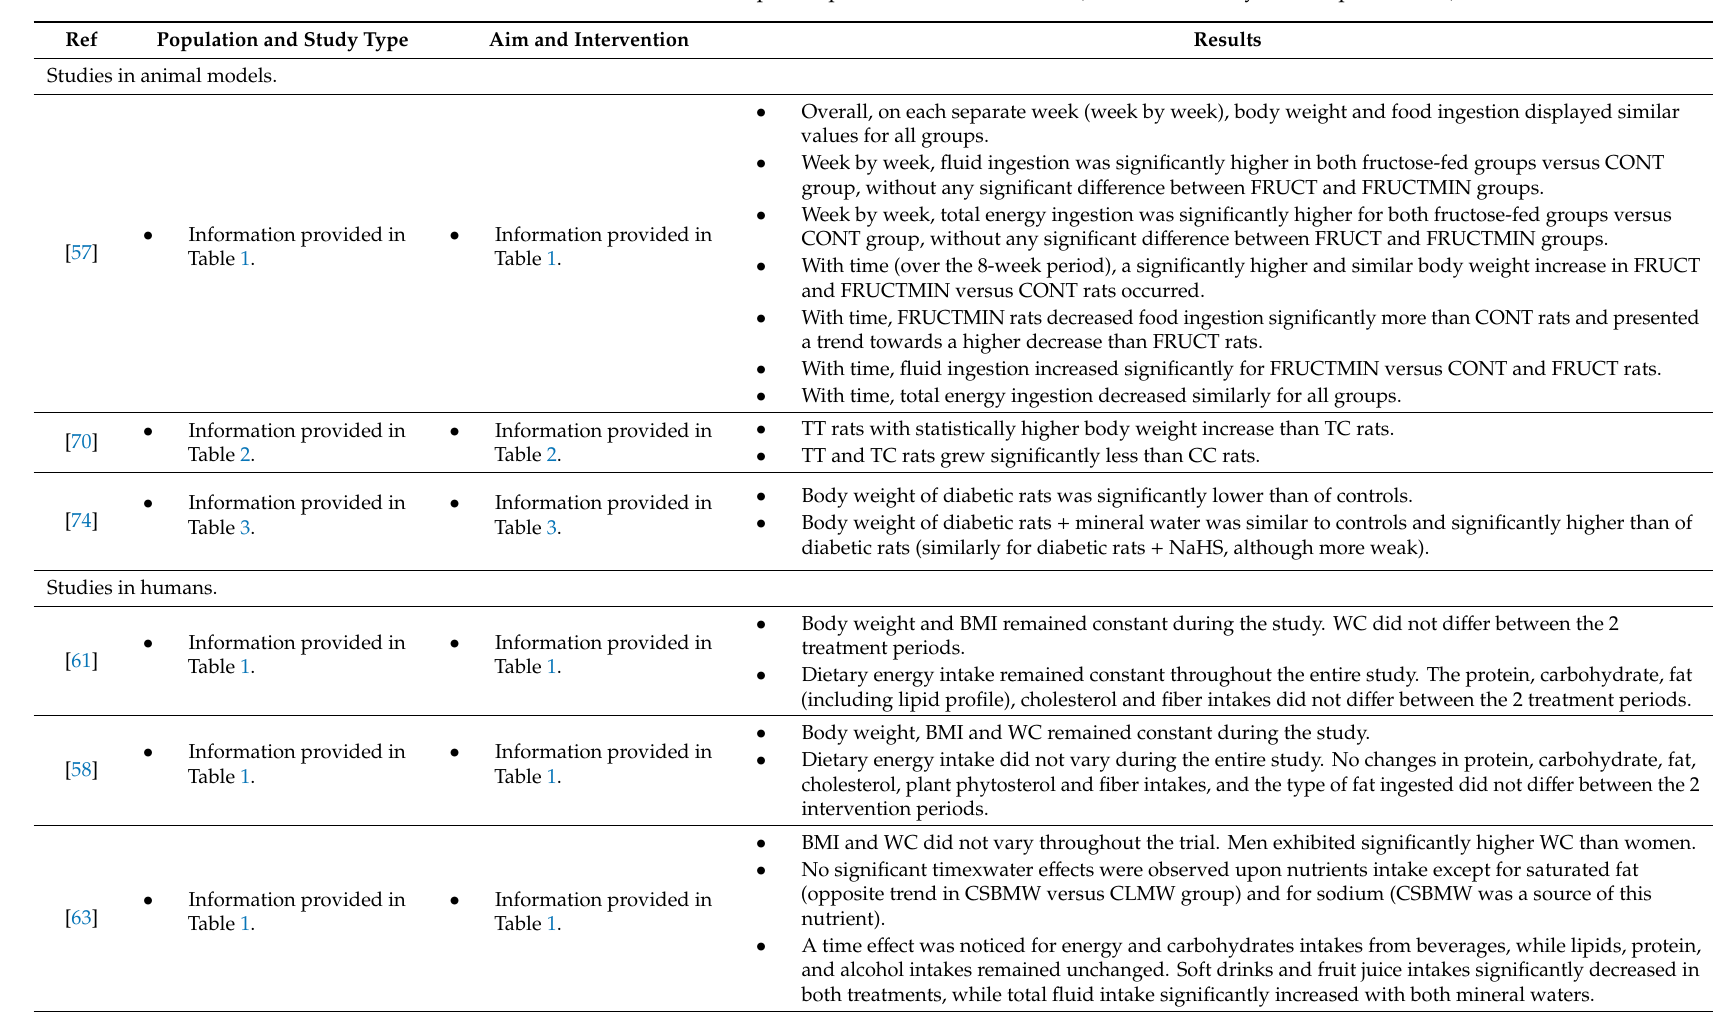
Table 4. The influence of mineral water consumption upon waist circumference (and other obesity-related parameters). Ref Population and Study Type Aim and Intervention Results Studies in animal